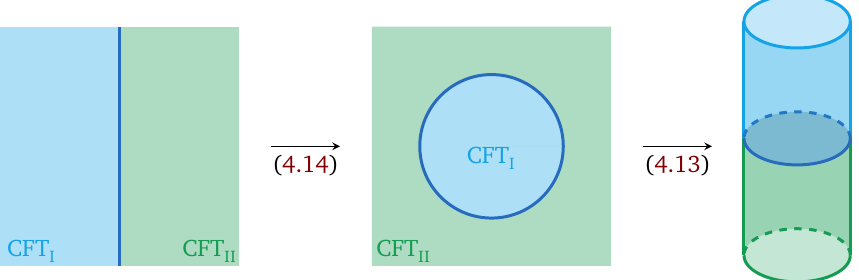
Figure 9: Series of transformations which map the ICFT from the plane to the cylin- der. The thermofield double state is obtained by cutting open the Euclidean path integral in the last picture along a vertical plane passing through the